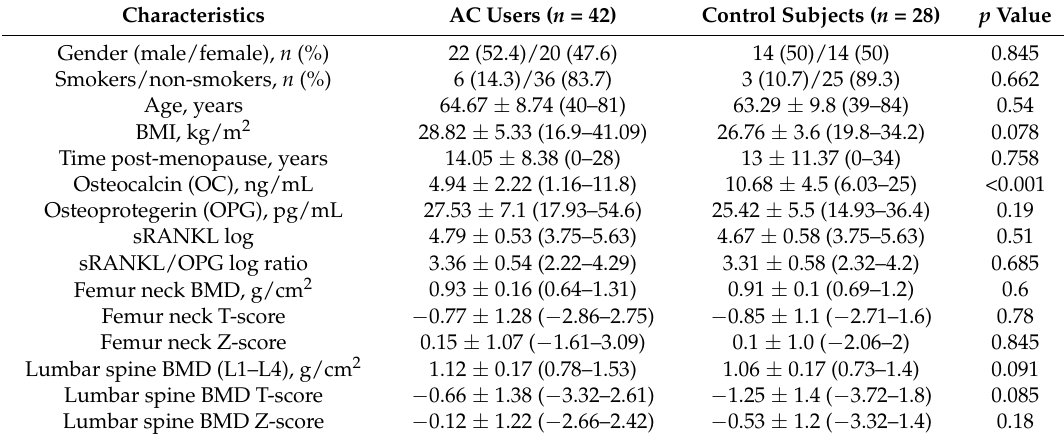
Table 1. Patients’ characteristics, biochemical parameters and BMD values in the study subjects.